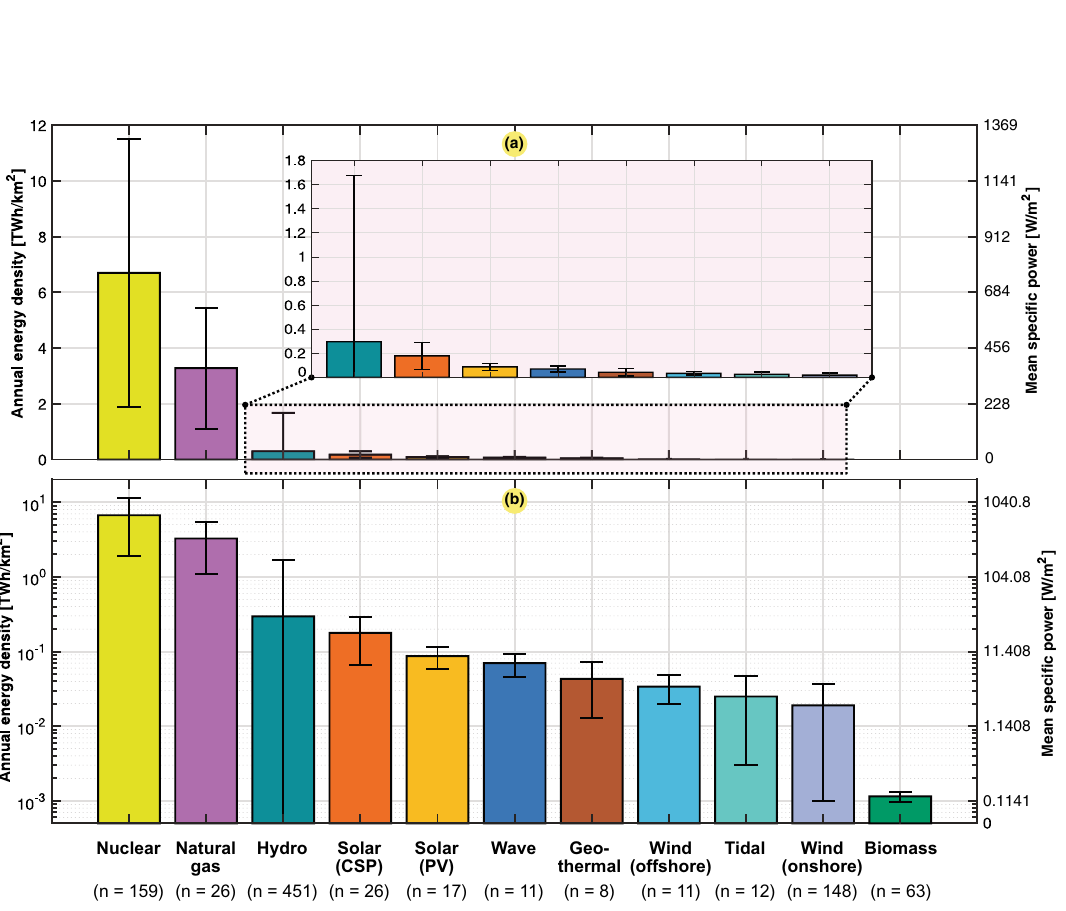
Figure 14. Overall result of the average values and standard deviations of the annual energy density ( e g ) or mean specific power ( p g ) for the different energy sources considered based on the output data provided in Table 16 (rooftop solar PV technology is excluded). ( a ) Linear scale. ( b ) Logarithmic scale. The biomass numbers are based on the meta-analysis of van Zalk and Behrens 3